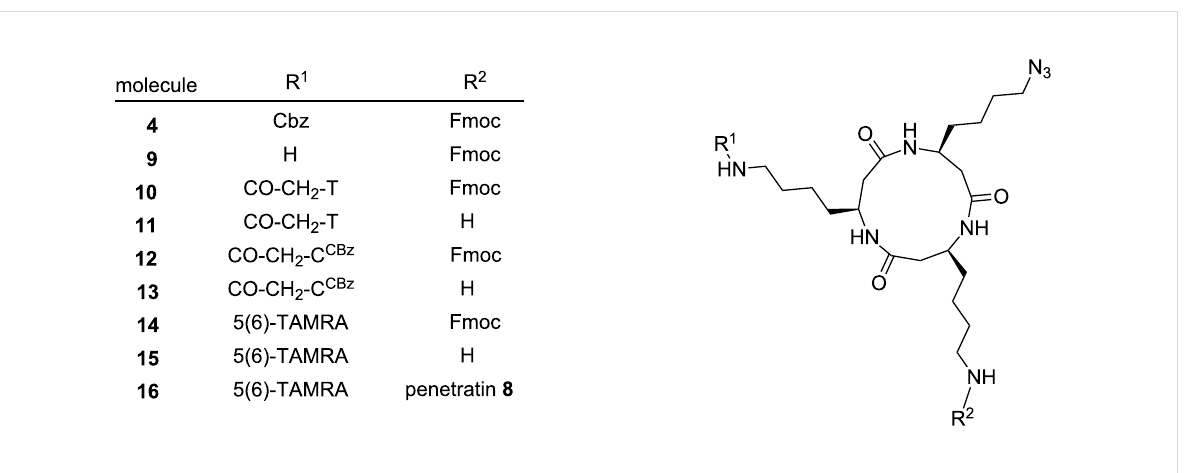
Figure 4: Cyclic β -tripeptides varying in two side-chain functionalities and containing an additional azide moiety, e.g., for ligation with click chemistry.